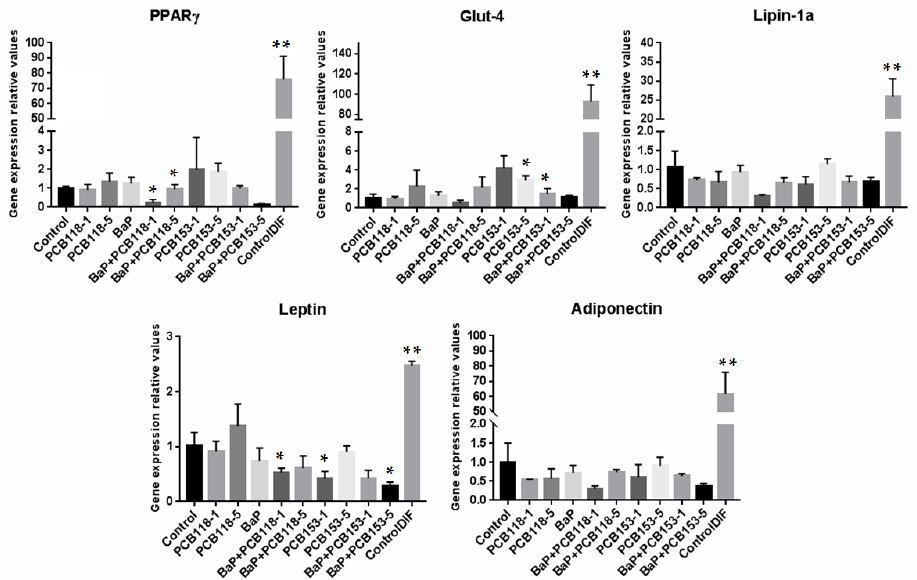
Figure A2. Effects of PCB118, PCB153 and BaP on undifferentiated 3T3-L1 cells on the expression of various adipogenesis related genes. Undifferentiated 3T3-L1 cells were incubated with or without PCB118 (one or five micromolars) or PCB153 (one or five micromolars) in the presence or not of BaP (one micromolar). Cells were washed twice with PBS and mRNA extraction and qRT-PCR were performed as described under materials and methods. Each incubation condition was carried out in quadriplicate and the experiment was repeated three times with similar results. The data are mean ± SD. The level of significance is given by comparison of treated trials with controls ( n = 4 per group): * p < 0.05; ** p < 0.01.